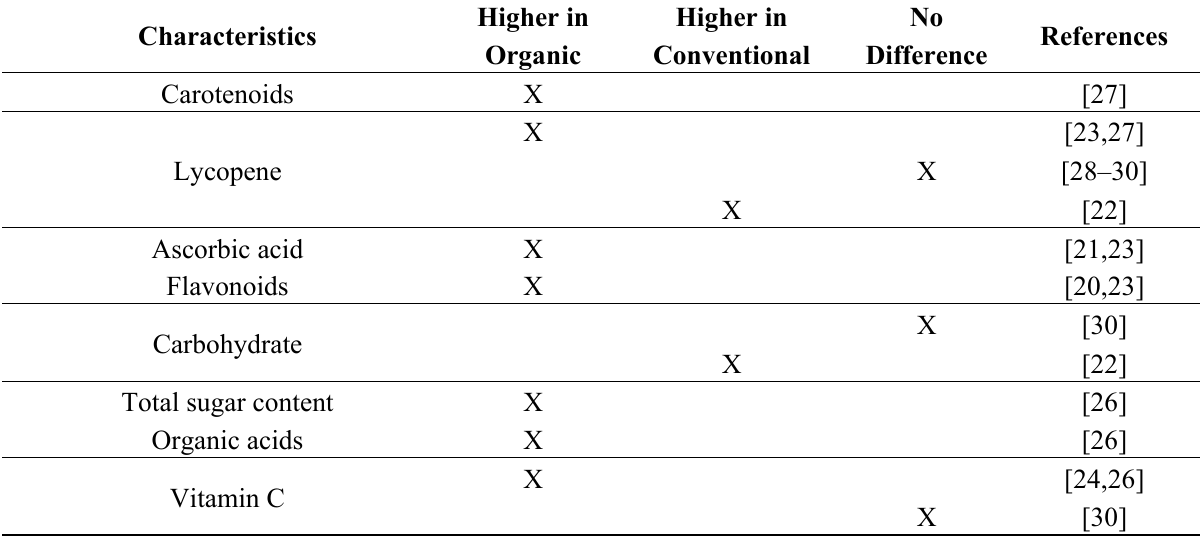
Table 1. Summary of the significant differences between conventional and organic tomato